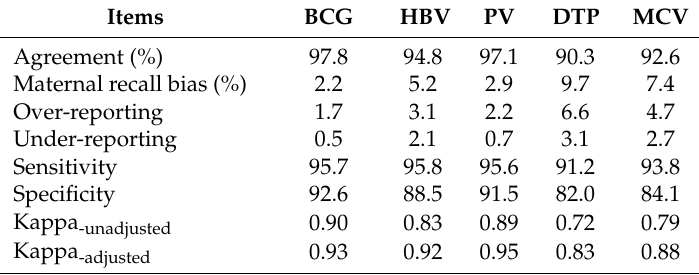
Table 3. Evaluations of agreement between record-based and recall-based data sources ( N = 648).